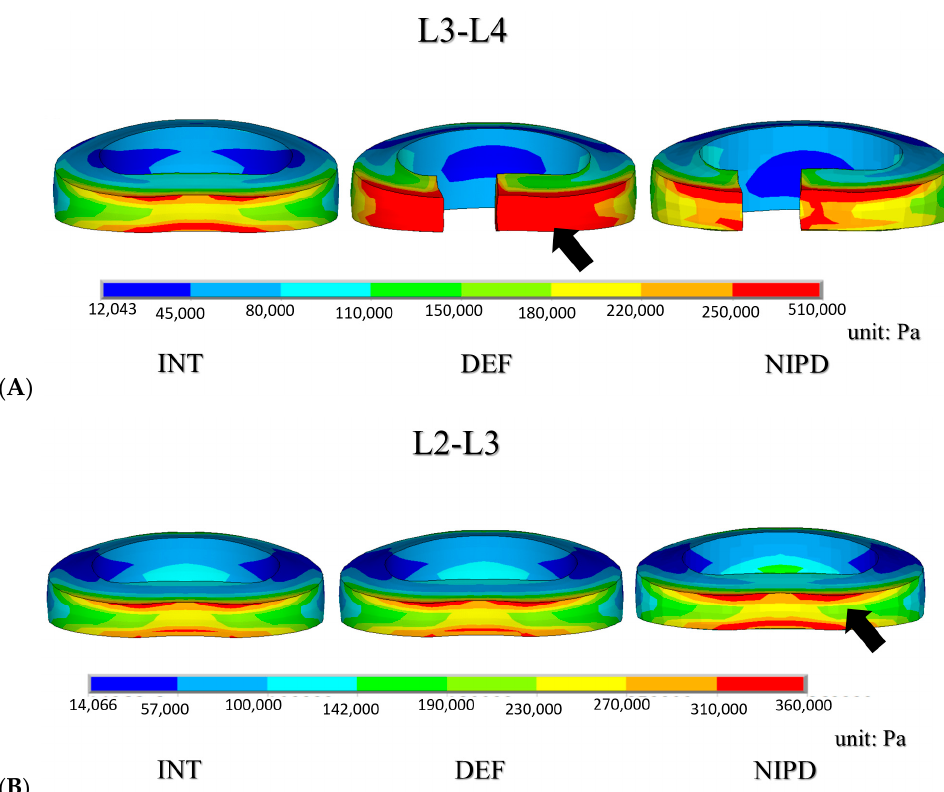
Figure 6. Stress distribution in the lumbar spine in the three FE models. Note: the circle indicates the location of the stress alteration. In the NIPD, the posterior element had higher stress (large area in red color), but the anterior vertebral body had lower stress (small area in yellow color).